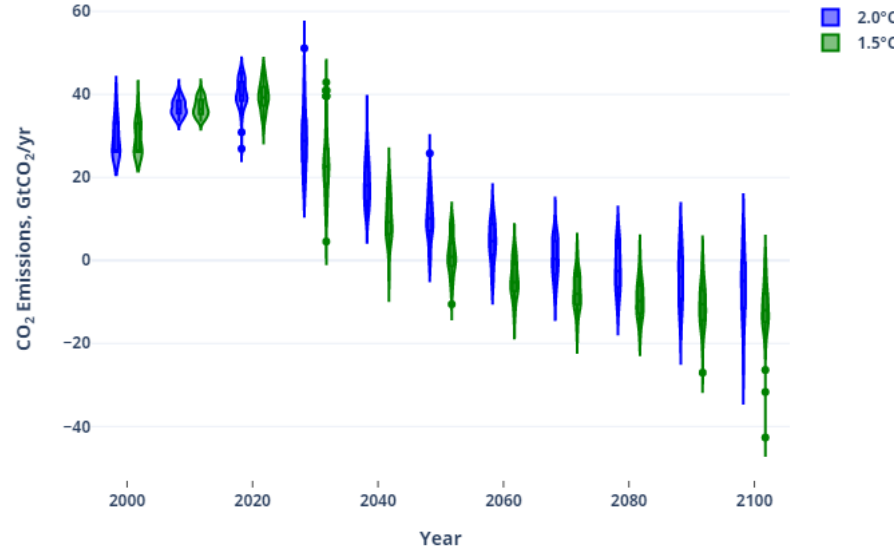
Figure 1. GHG emissions distribution over time for SSP scenarios. Sources: [15,16]. 2 °C/1.5 °C scenarios are defined as having a more than 66%/50% chance of having a temperature change of 2 °C/1.5 °C, according to